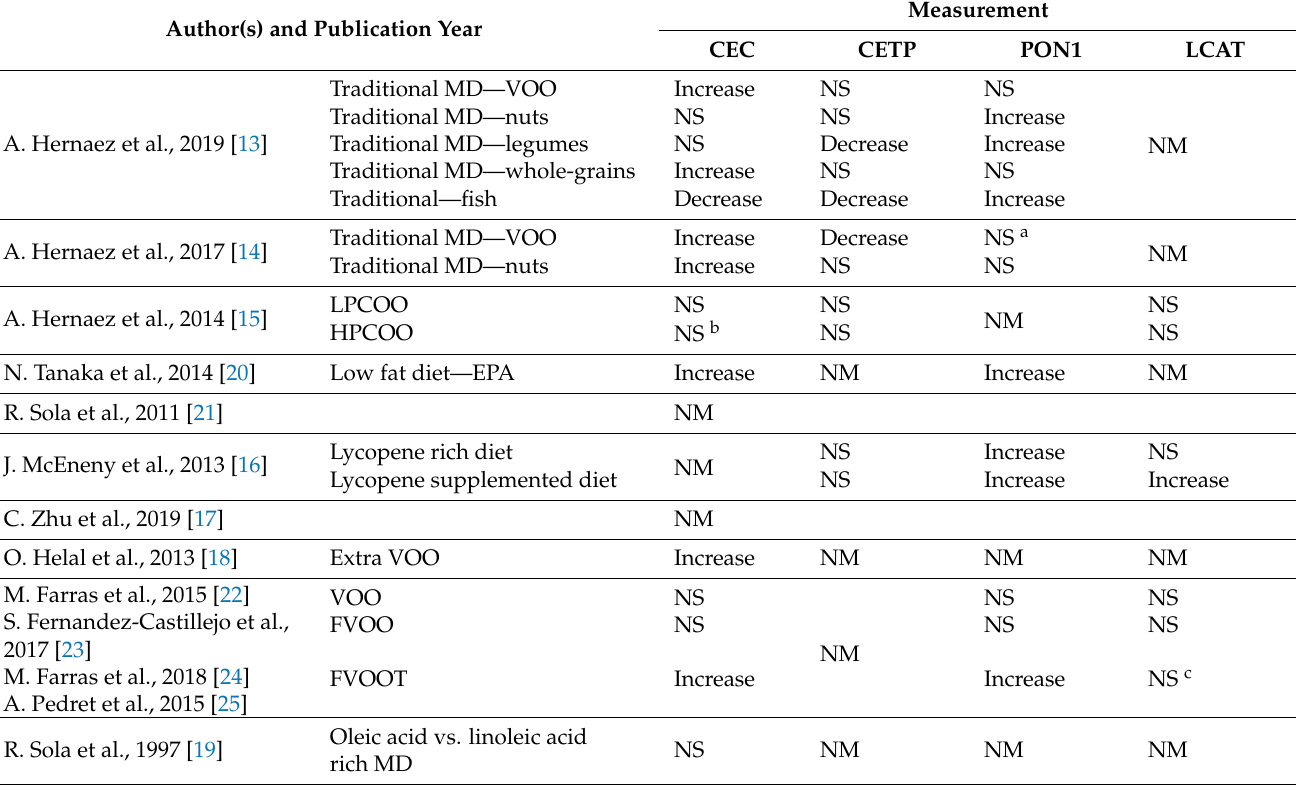
Table 3. High-density lipoprotein (HDL)